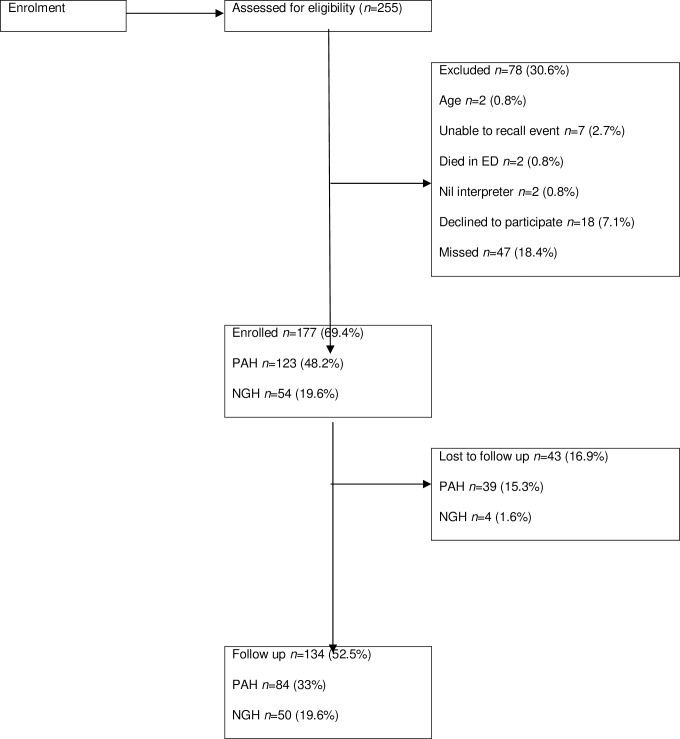
Participant flow diagram.ED, emergency department; PAH, Princess Alexandra Hospital; NGH, Nambour General Hospital.